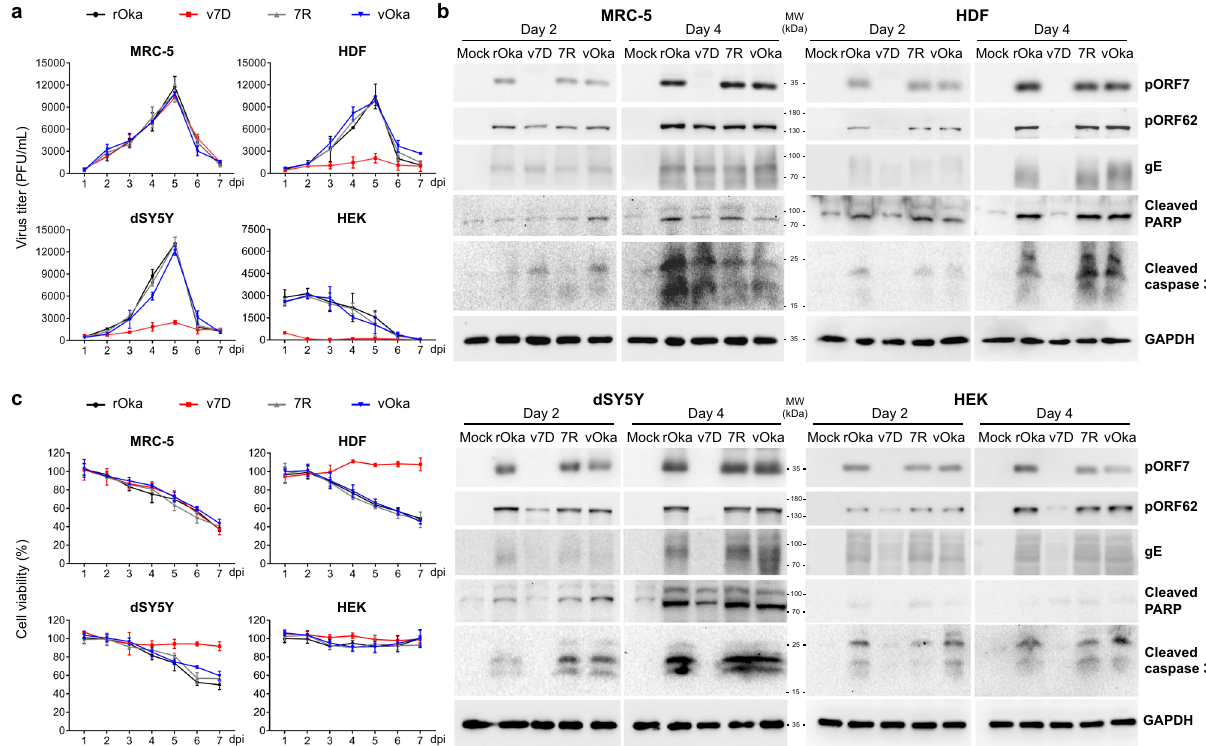
Fig. 1 v7D is severely attenuated in human skin and neuronal cells in vitro. MRC-5 cells, dSY5Y cells, HDFs, and HEKs were mock-infected or infected with cell-free rOka, v7D, 7R, and vOka, respectively. For MRC-5 cells, dSY5Y cells and HDFs, MOI = 0.01. For HEKs, MOI = 0.2. a Infected cells were harvested daily over a period of 1 week and viral titers were determined by plaque assay in MRC-5 cells to generate growth curves; b Lysates were prepared from the harvested cells at 2 and 4 dpi and tested by western blot for markers of viral translation (exempli fi ed by viral proteins pORF7, pORF62 and gE, more in Supplementary Fig. 2) and host cell damage/death (PARP and caspase-3 cleavage); c The cell survival was measured by CCK-8 assay at indicated time points after infection. The results are represented as averages± the SD ( n = 3 per group). The experiments were repeated twice, and representative results are shown. Source data are provided as a Source Data fi